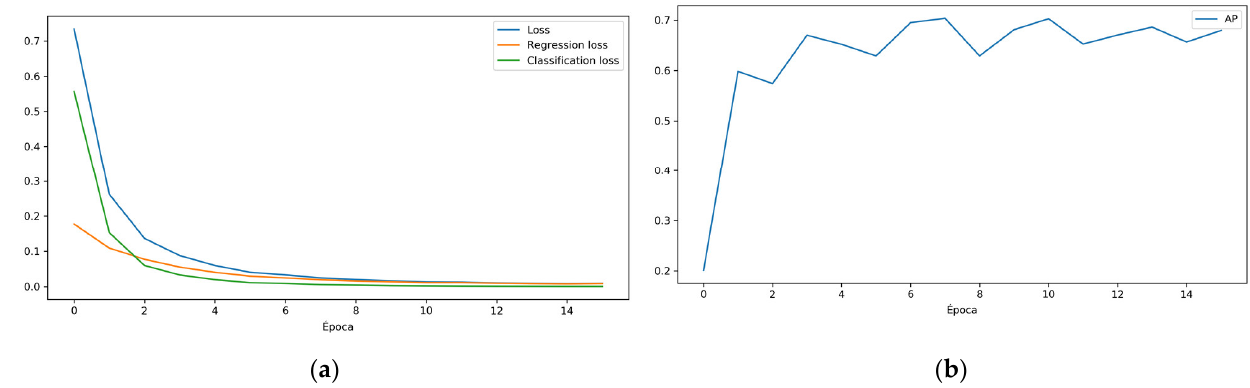
Figure 4. ( a ) Loss, regression loss and classification loss for each training epoch; ( b ) AP by epoch.